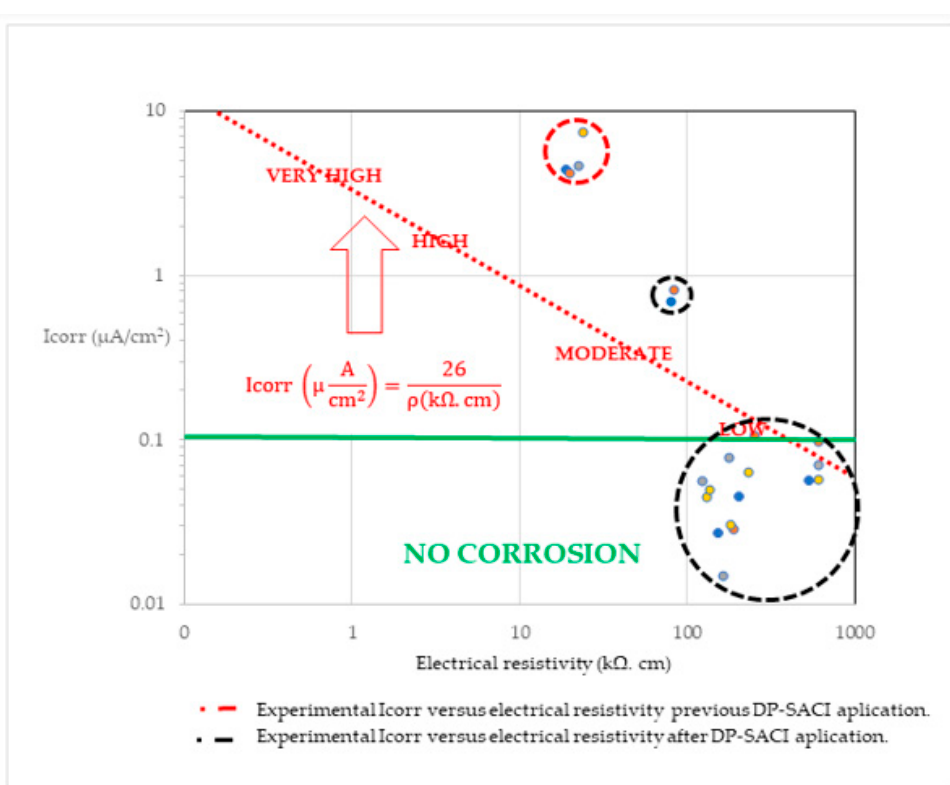
Figure 13. Plot of experimental and theorical Icorr versus experimental electrical resistivity.